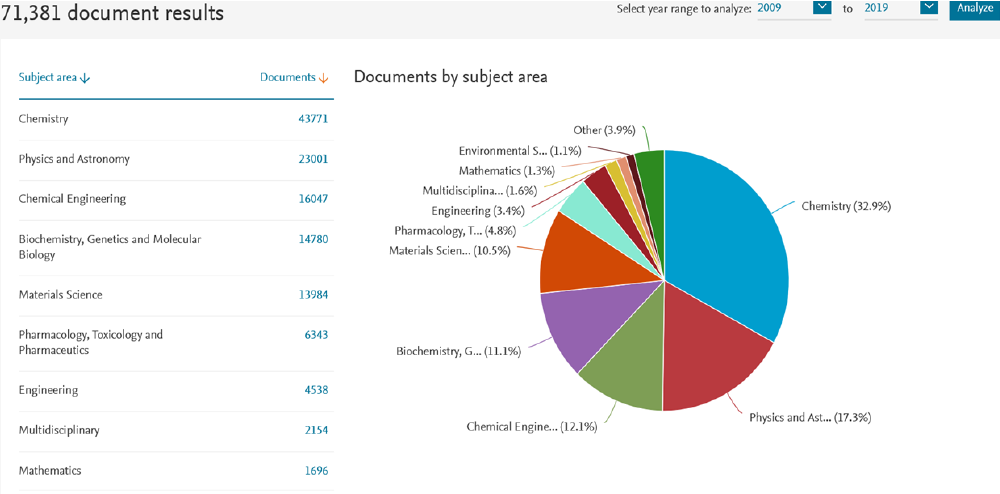
Figure 1. Results analysis for Scopus query “chiral” in titles, keywords, or the abstract section of articles between 2009 and 2019.